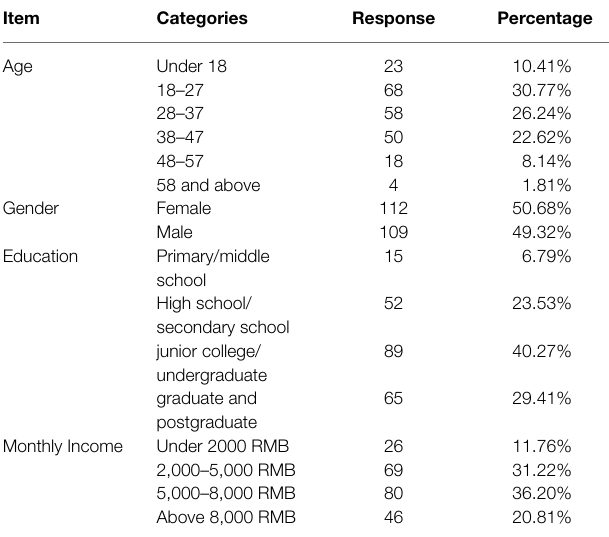
TABLE 2 | Respondents’ demographic information.